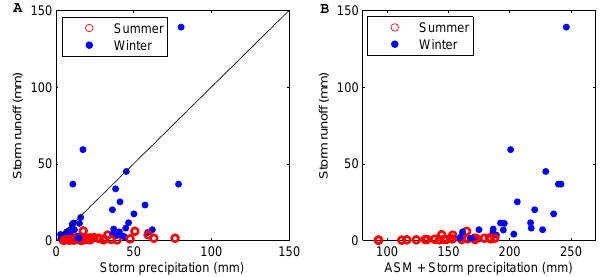
Figure 5. (a) Storm runoff against storm precipitation, split by sea- son. The definition of a storm event is described in Sect. 3.6. No baseflow separation was used, leading to two events where storm runoff includes a component of pre-storm water and exceeds storm precipitation. (b) Storm runoff against the sum of storm precipita- tion and antecedent soil moisture storage (ASM), split by season. ASM was taken as the total soil moisture value from Eq.